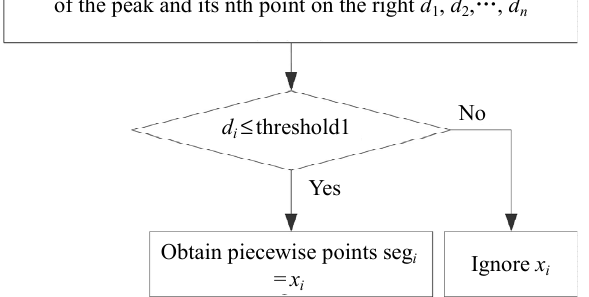
Fig. 1 Flow chart for selection of segmentation